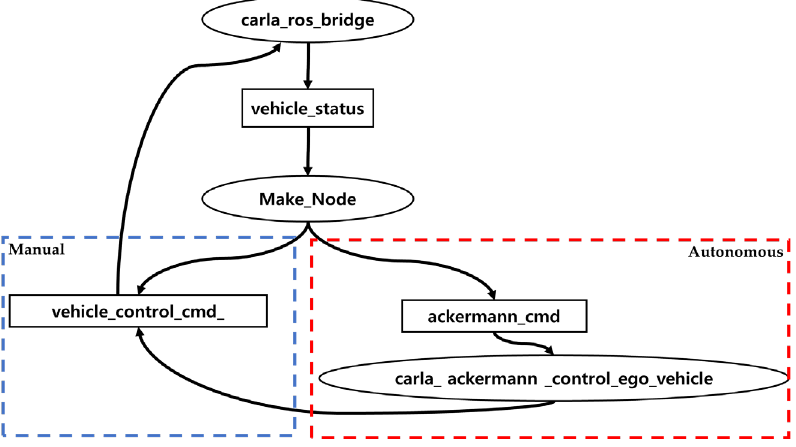
Figure 2. Rqt-graph of vehicle control for semi-autonomous driving.